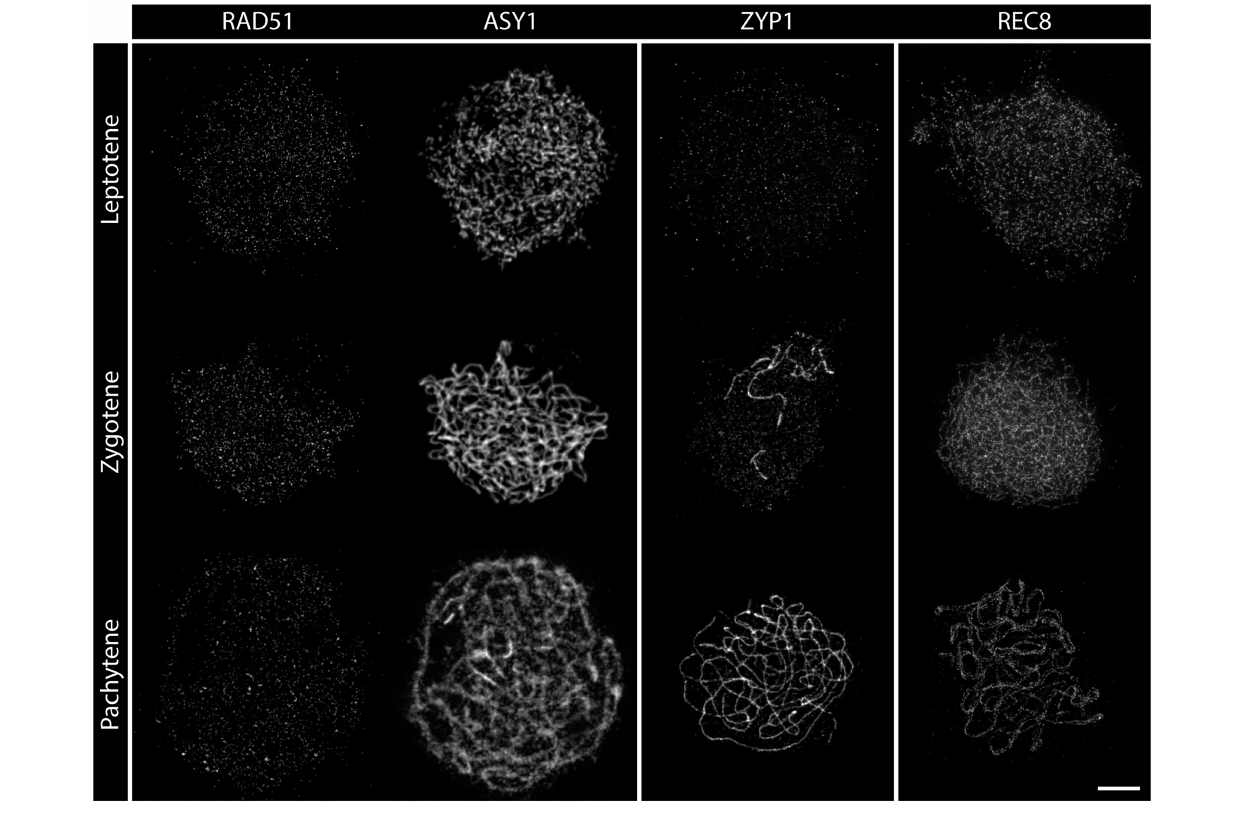
FIGURE 5 | Detergent-spread nuclei from pollen mother cells depicting the meiotic progression in the wild type. The spread nuclei were stained for the recombinase RAD51, the axial element protein ASY1, the transverse filament protein ZYP1, or the cohesin subunit REC8. Images were acquired with a STED nanoscope. Stages of meiotic prophase are indicated. Scale Bar: 2 μ